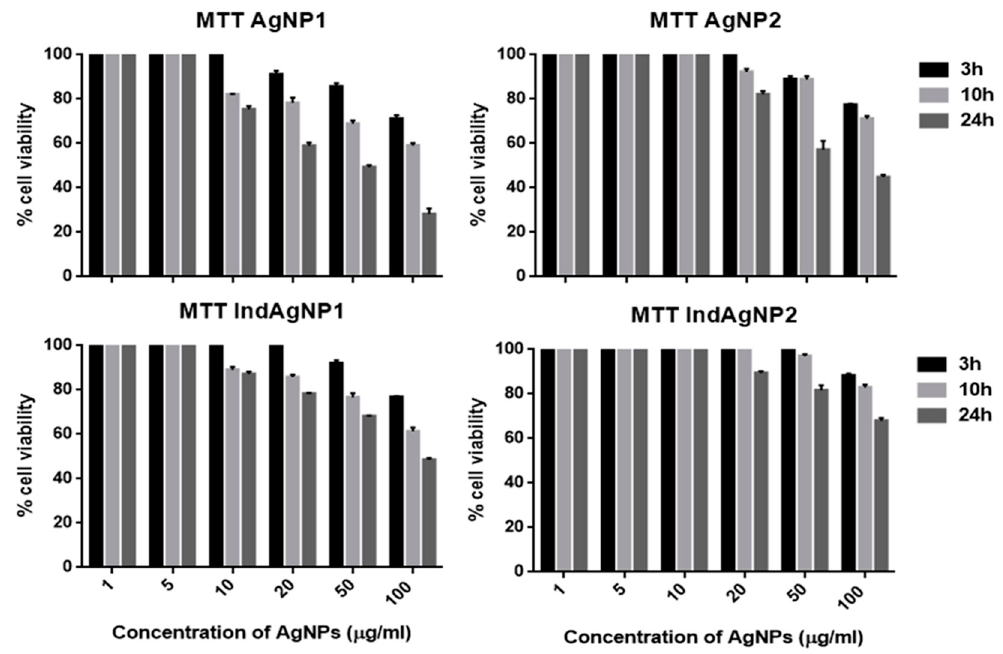
Figure 4. Cytotoxicity evaluation of AgNPs via MTT assay. Vero cells were treated for 3, 10, and 24 h with different concentrations of NPs ( μ g/mL).